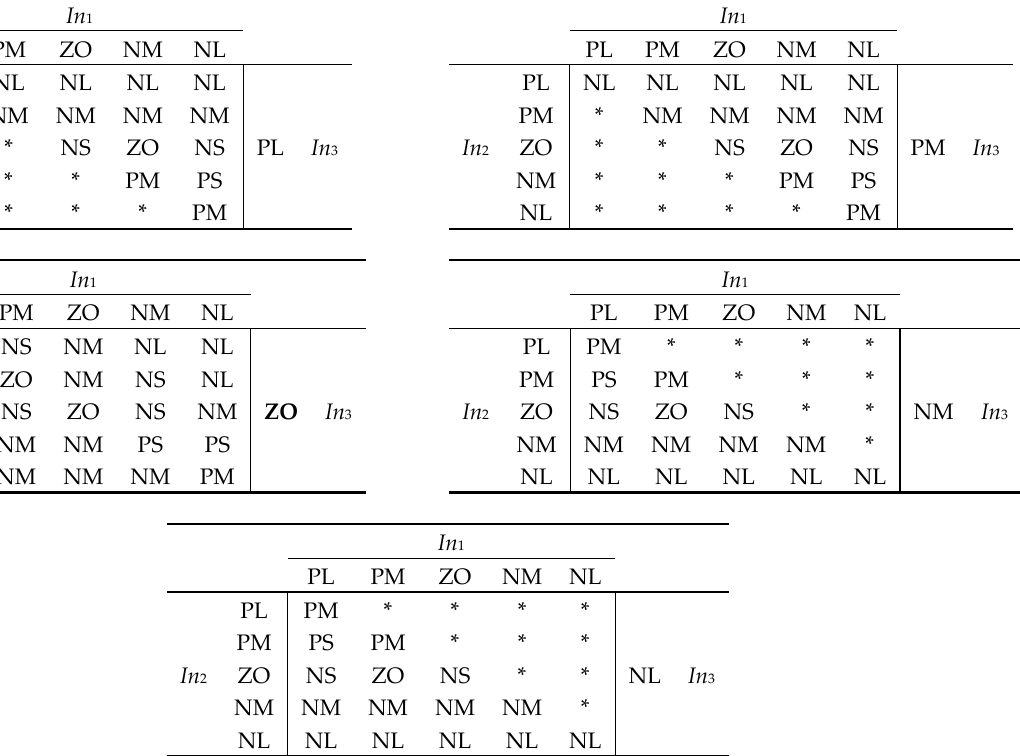
Table 1. Fuzzy control rules for the proportional gain. Tables 1. Fuzzy control rules for the proportional gain.